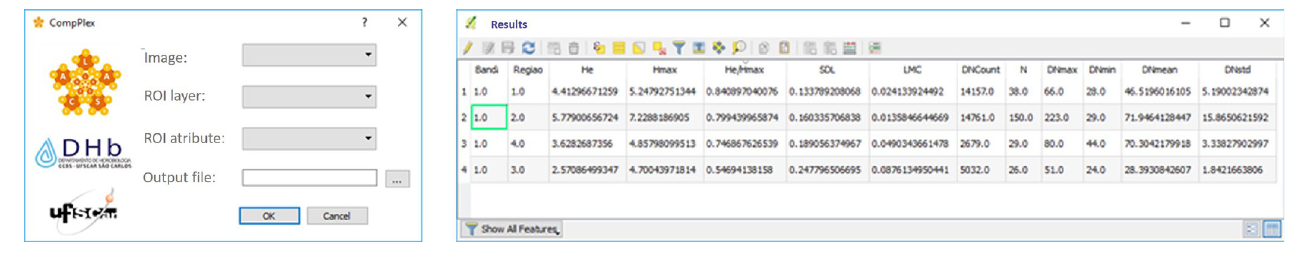
Fig 4. CompPlex HeROI toolbox interface (left) and its results table